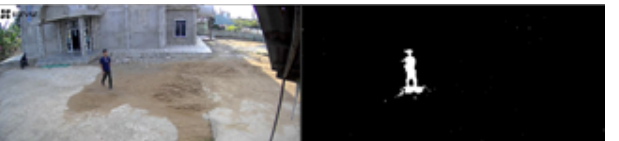
Figure 7. Example of moving object segmentation results with the ViBe conservative update.